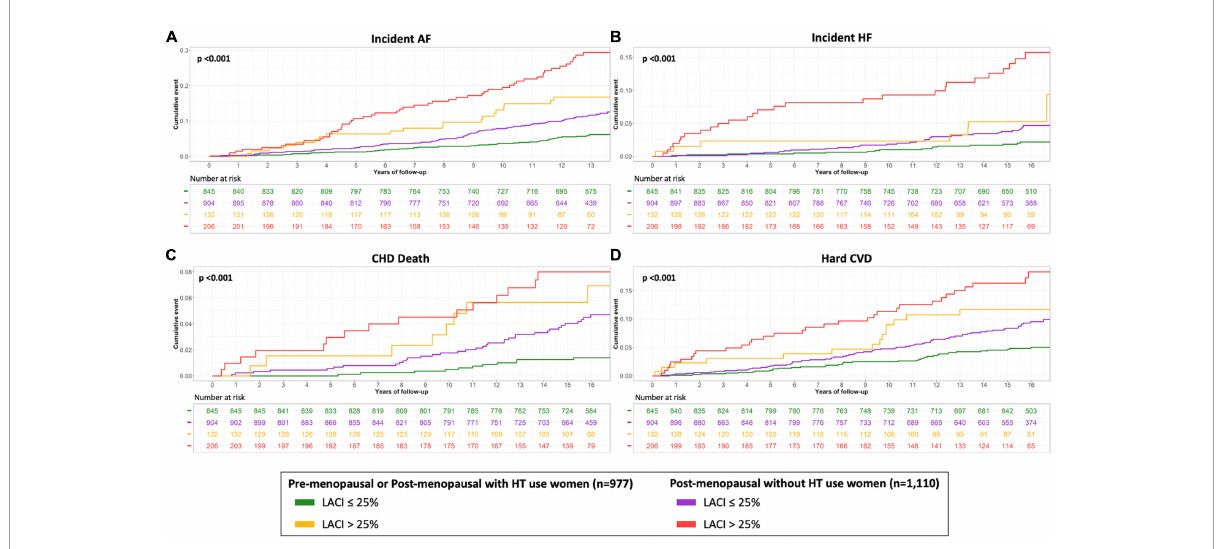
FIGURE5 Kaplan–Meier survival curves for incident AF (A) , incident HF (B) , CHD death (C) and hard CVD (D) according to the menopausal status and HT use stratified by LACI > 25%. The cumulative hazard was systematically significantly greater in the third quartile compared with the other terciles for each outcome (log-rank for difference; p <